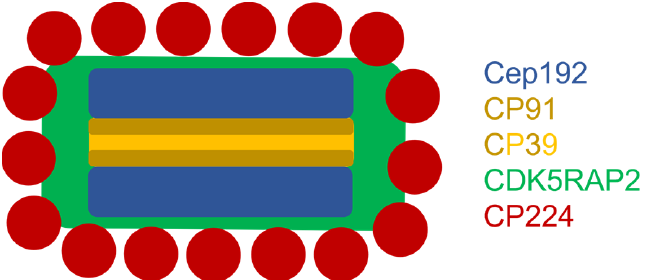
Figure 8. Schematic drawing of the topology of the investigated proteins at the Dictyostelium centrosome. Depicted is a cross section through the centrosome: CP91 resides in the inner core layer as two distinguishable layers (darker yellow) and in close proximity to Cep192 (blue), which is located in the outer core layers. CP39 (yellow) also locates in the inner core layer. CDK5RAP2 (green) is a protein closely associated with the core structure and locates in the corona together with CP224 (red).